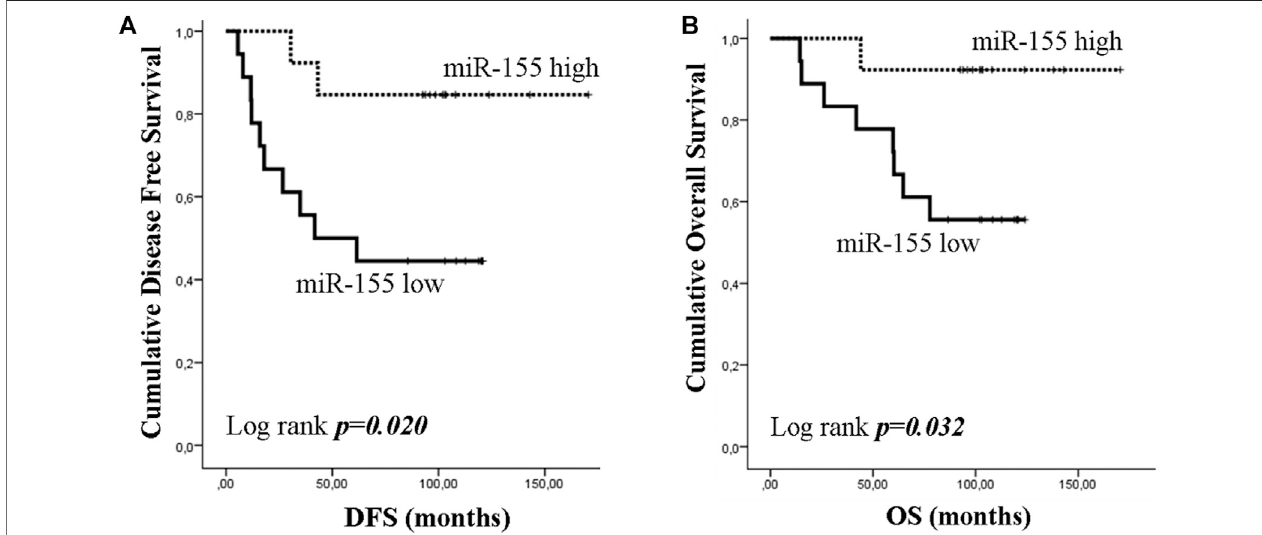
FIGURE7| Kaplan – Meieranalysisfordiseasefreesurvival(DFS)andoverallsurvival(OS)accordingtotheexpressionofcirculatingmiR-155intriplenegativebreast cancer(TNBC) group. Patients were classi fi edaccording tomedian valueofmiR-155 expression.DFS (A) and OS (B) in patients withhigh or lowmiR-155. Curves were compared using the log rank test. P values are shown.